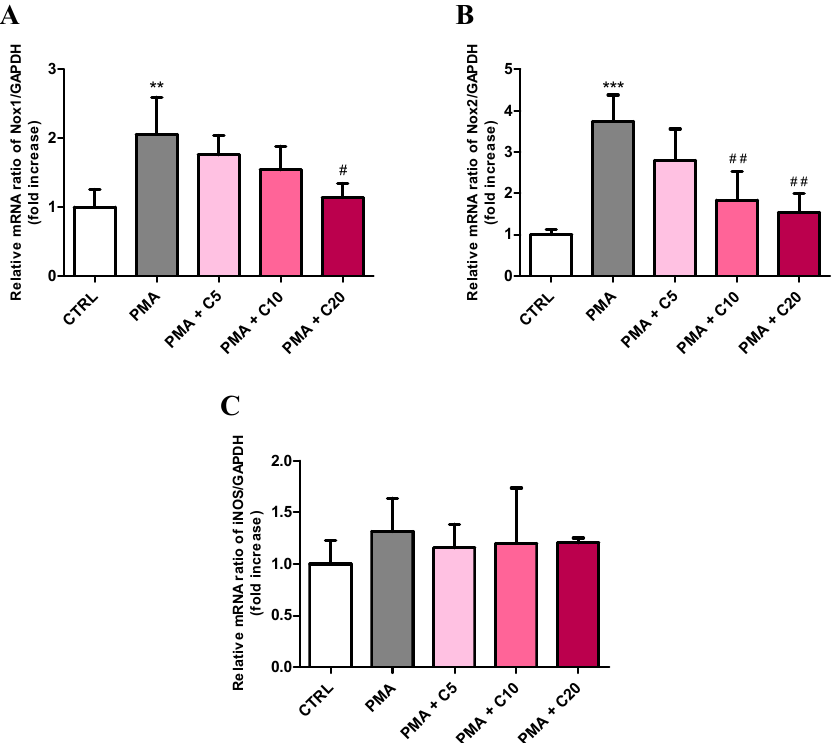
Figure 4. Measurement of ( A ) Nox1, ( B ) Nox2, and ( C ) iNOS mRNA expression levels (quantitative real-time PCR (qRT-PCR)) in resting (control) macrophages and in macrophages stimulated with PMA and SOD inhibitors, in absence or presence of increasing concentrations (5, 10, or 20) of carnosine. The abundance of each mRNA of interest was expressed relative to the abundance of GAPDH-mRNA, as an internal control. As a negative control, a reaction in absence of cDNA (no template control, NTC) was performed. Values are means ± SD of three to seven independent experiments. ** p < 0.01 vs. CTRL; *** p < 0.001 vs. CTRL; # p < 0.05 vs. PMA; ## p < 0.01 vs. PMA.